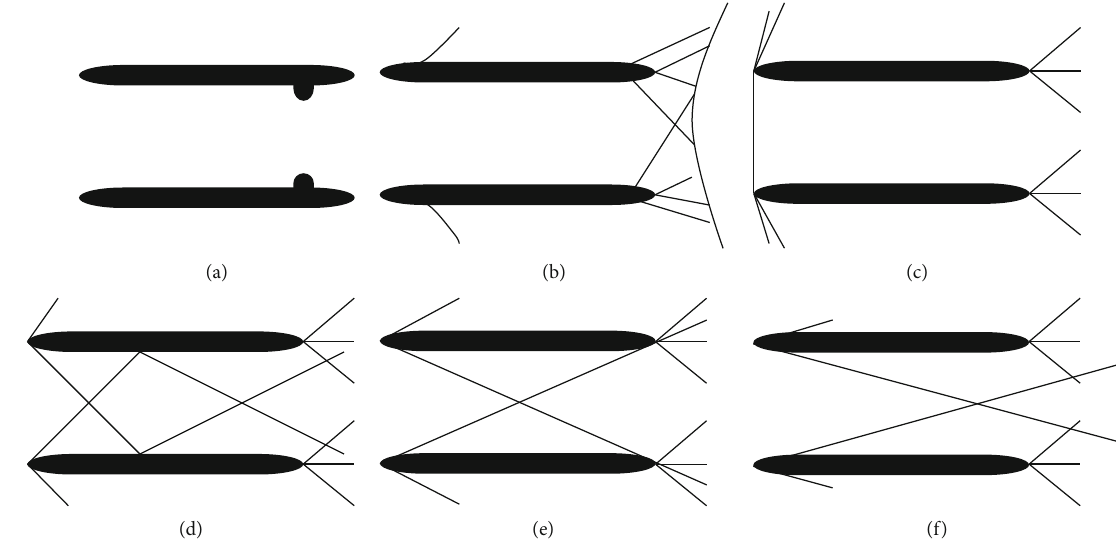
Figure 2: Flow state between grid wing partitions with di ff erent critical Mach numbers.